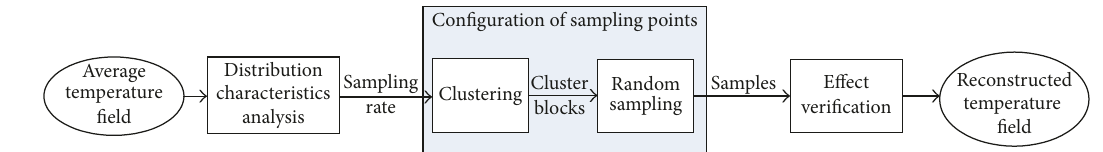
Figure 1: Optimal configuration method of sampling points.